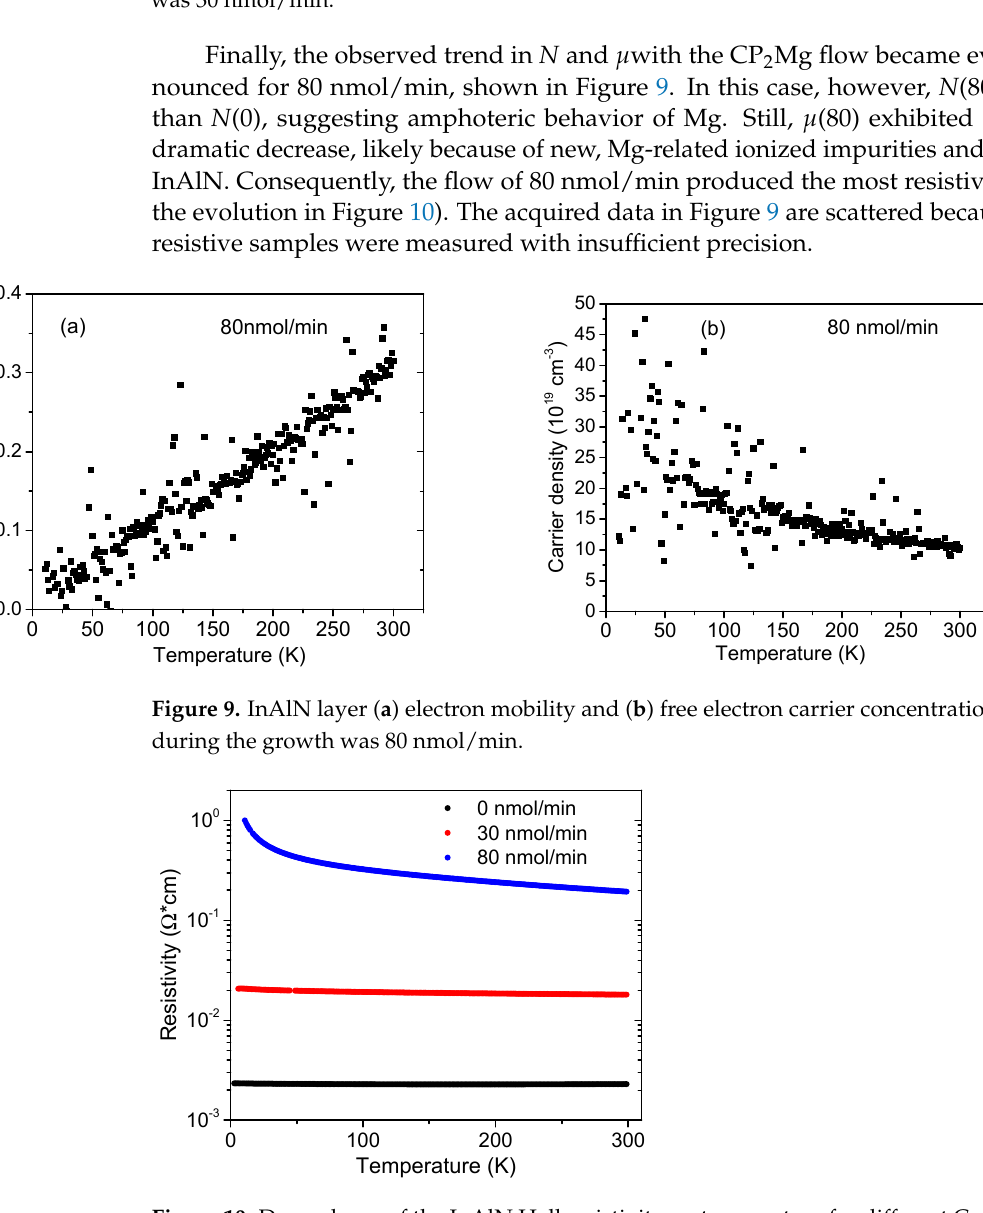
Figure 10. Dependence of the InAlN Hall resistivity on temperature for different Cp 2 Mg flows.